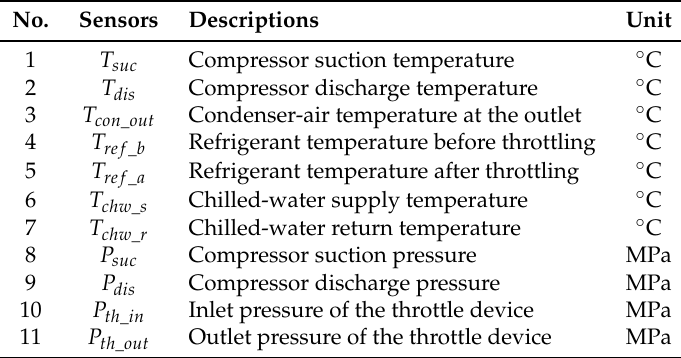
Table 1. The descriptions of the eleven sensors.